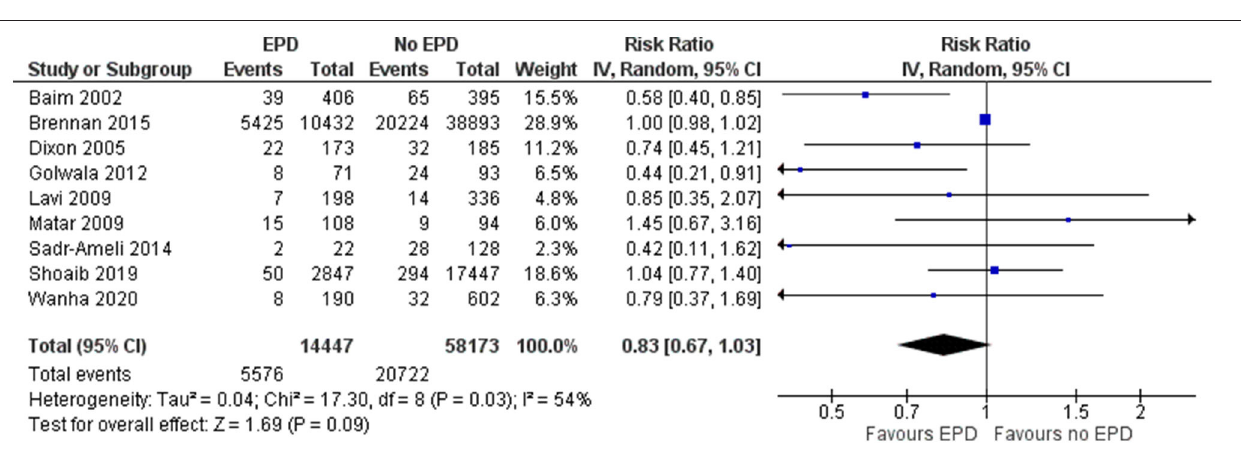
FIGURE 6 | Forest plot showing the difference in major adverse cardiovascular events (MACE) between patients with and without